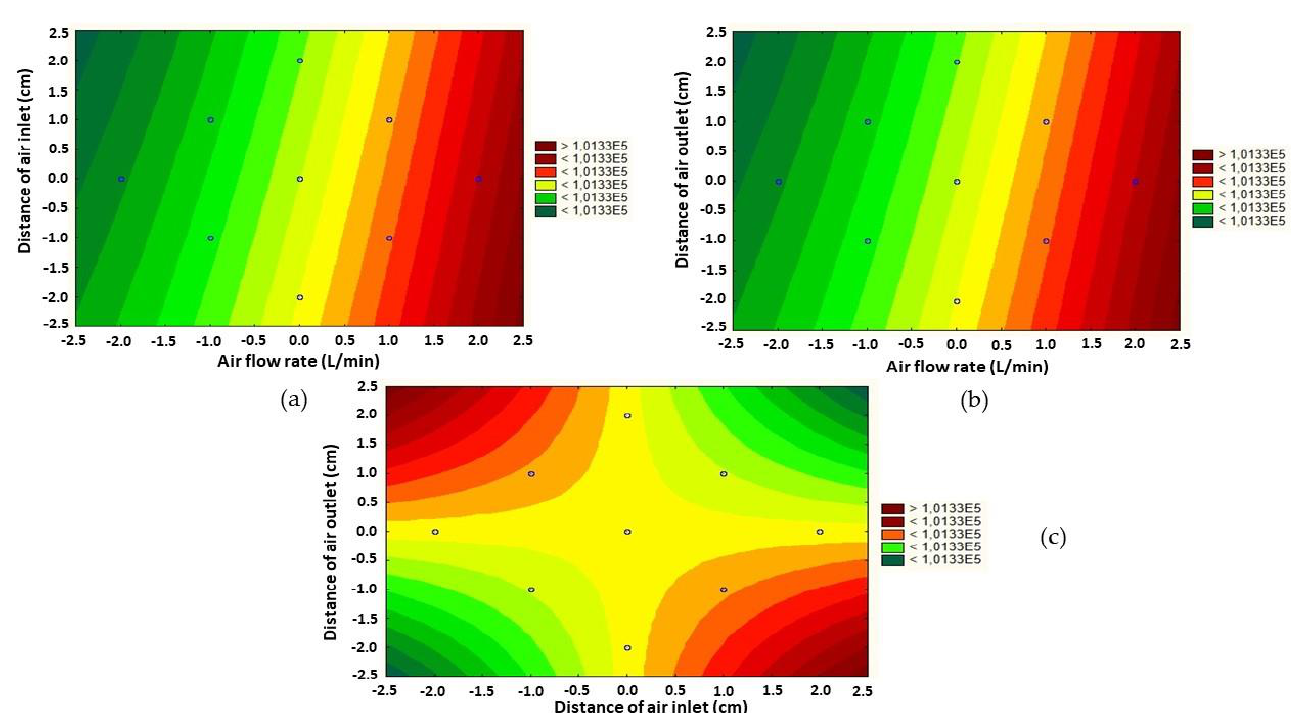
Figure 20. 2D contour graph of the interaction effects for the lateral air inlet and outlet geometry. Simultaneous effects on internal pressure exerted by ( a ) distance of air inlet and air flow rate; ( b ) distance of air outlet and air flow rate; ( c ) distance of air inlet and distance of air outlet.